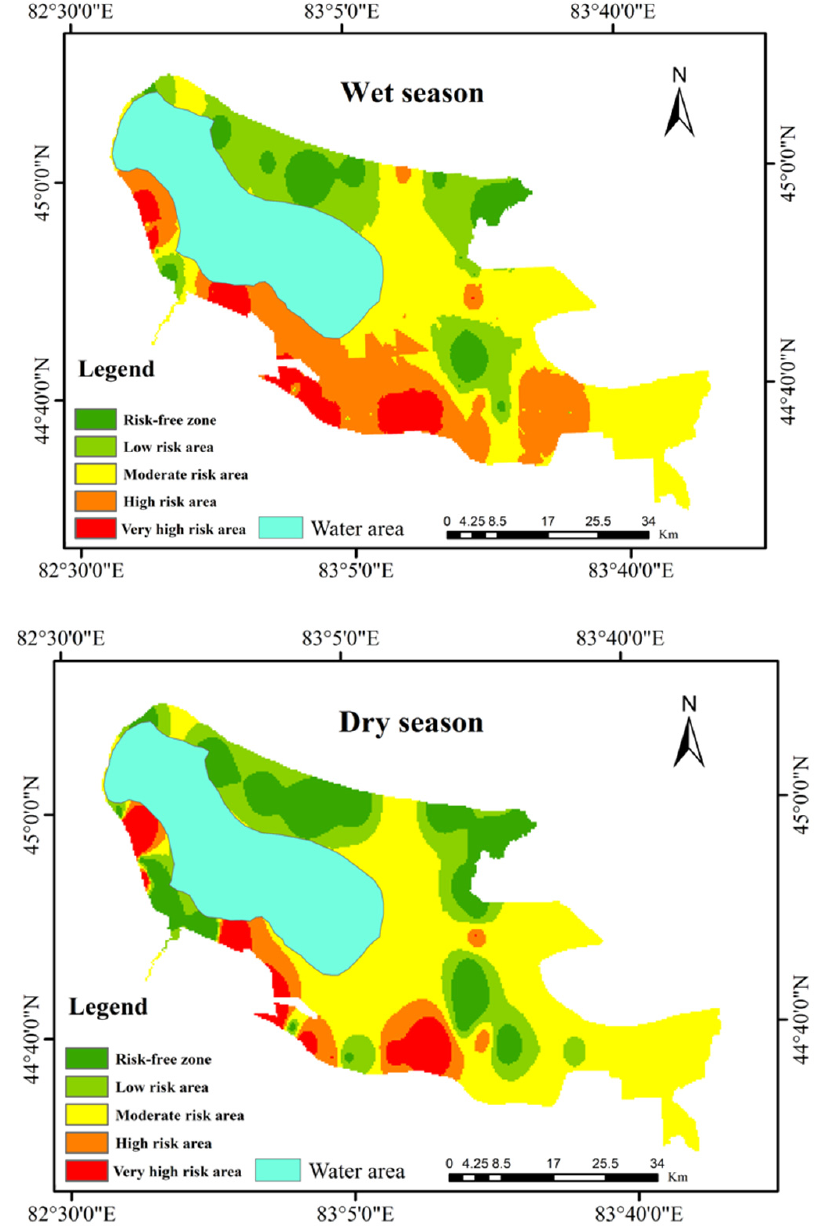
Figure 9. Spatial risk profile in wet and dry seasons.